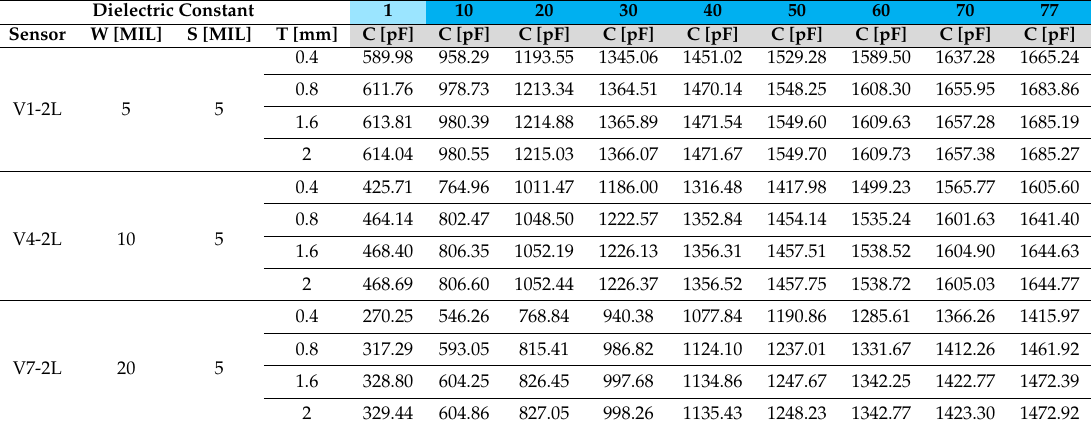
Table 2. Simulation and measurement results for the structures designed on variable thickness PCB. The environment is air ( (cid:101) r = 1) or distilled water ( (cid:101) r swept from 10 to 77). Capacitance is listed as absolute value in pF in all the